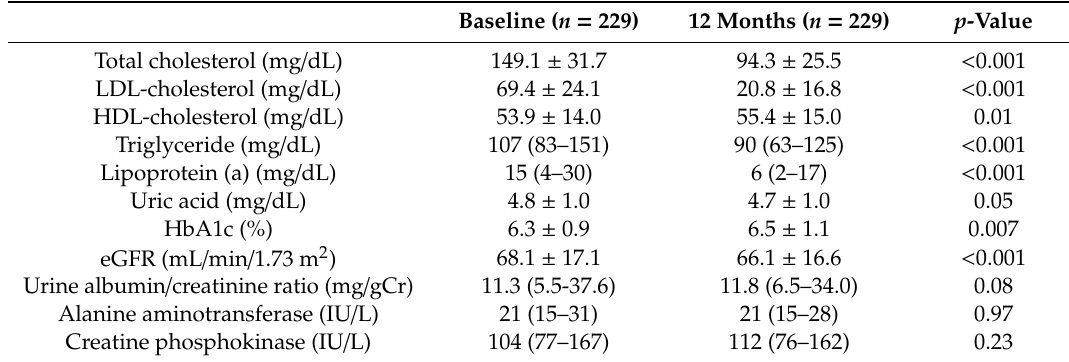
Table 5. Laboratory parameters before and after 12 months of evolocumab